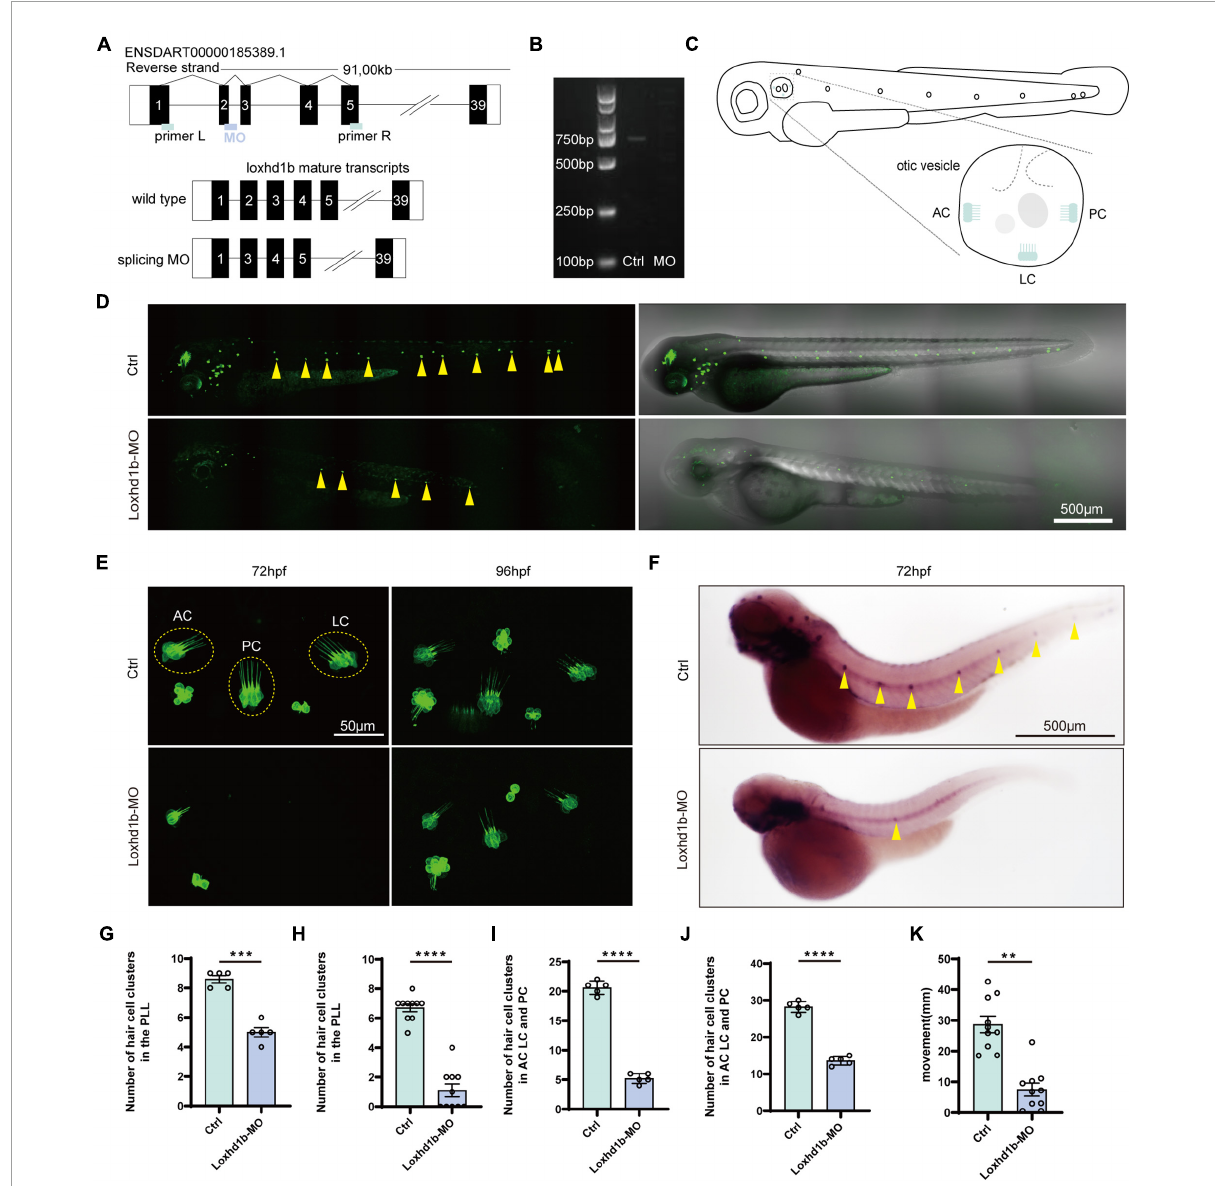
FIGURE2 Effect of Loxhd1b knockdown on decreasing the number of hair cells in the otic vesicle and posterior lateral line of zebrafish. (A) The targeting site of Loxhd1b splice blocking morpholino and the PCR primer design for validating the knockdown analysis. The wild type mature transcripts indicate the natural splicing product of Loxhd1b mRNA. The splicing MO mature transcripts indicate the abnormal splicing product of Loxhd1b mRNA with Exon 2 deletion caused by morpholino injection. (B) Effectiveness of Loxhd1b knockdown confirmed by PCR. (C) The schematic for three clusters of cristae hair cells in the otic vesicle. ACHC, anterior cristae hair cells; LCHC, lateral cristae hair cells; PCHC, posterior cristae hair cells. (D) Fluorescence microscopic imaging analysis of Loxhd1b knockdown line at 3 dpf. Arrowheads indicate hair cell clusters. Scale bar = 500 µ m. (E) Confocal imaging analysis of cristae hair cells in the otic vesicle of control and Loxhd1b deficiency zebrafish at 72 and 96 hpf. Scale bar = 50 µ m. (F) WISH experiments of the eya1 gene and the imaging analysis of control, claudin h morphants, and rescued zebrafish at 96 hpf in bright field. Scale bar = 500 µ m. (G) Statistical analysis of zebrafish lateral line neuromast at 72 hpf. (H) Statistics of zebrafish lateral line neuromasts at 96 hpf. (I) Statistical analysis of the number of different cristae hair cells in the inner ear of control and Loxhd1b -MO in 72 hpf. (J) Statistical analysis of the number of different cristae hair cells in the inner ear of control and Loxhd1b-MO in 96 hpf. (K) C-startle response in Loxhd1b morphants zebrafish larvae was significantly lower than that in control zebrafish. ** P < 0.01, *** P < 0.001, and **** P < 0.0001.